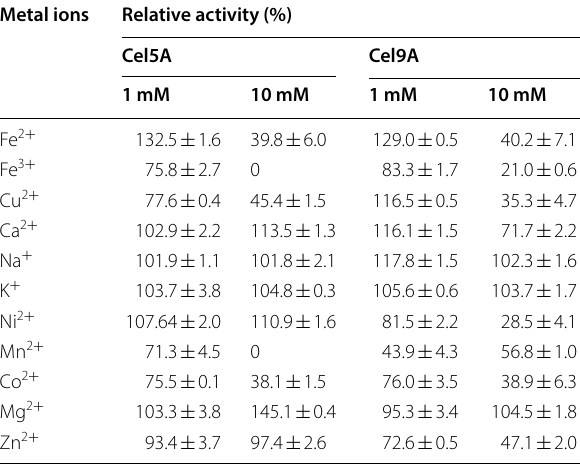
Table 1 Effect of metals on recombinant enzymes Metal